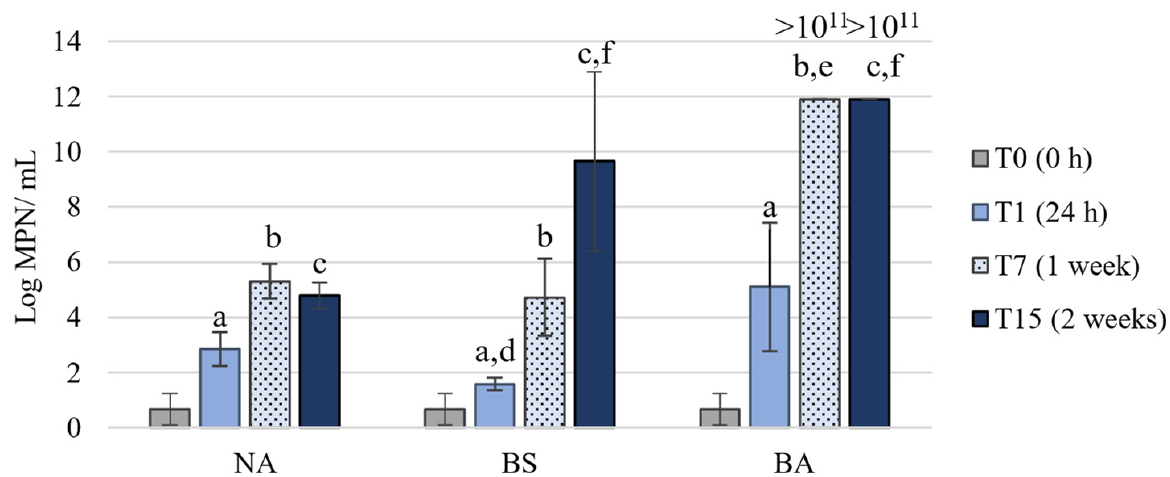
Figure 3. Visual aspect of the microcosm flasks at the beginning (T0), after 7 days of experiment (T7) and at the end of the experiment (after 15 days) (T15), for the different treatments: natural attenuation (NA), biostimulation (BS) and bioaugmentation with an inoculum of lyophilized consortia.